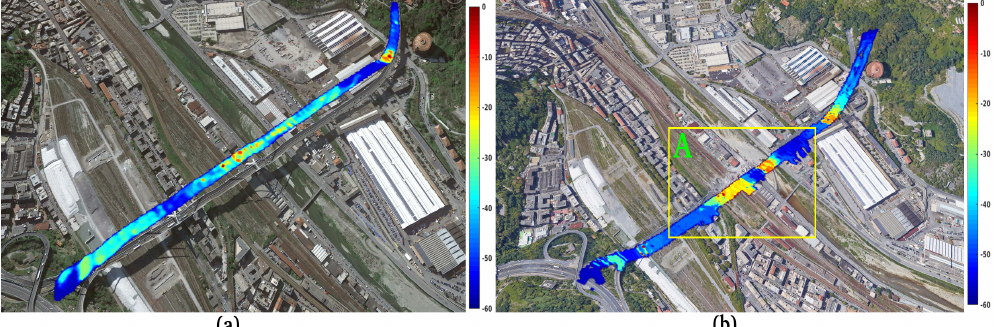
Figure 27. Vibration maps of the “Morandi” bridge: ( a ) 21 January 2016, ( b ) 5 July 2018.